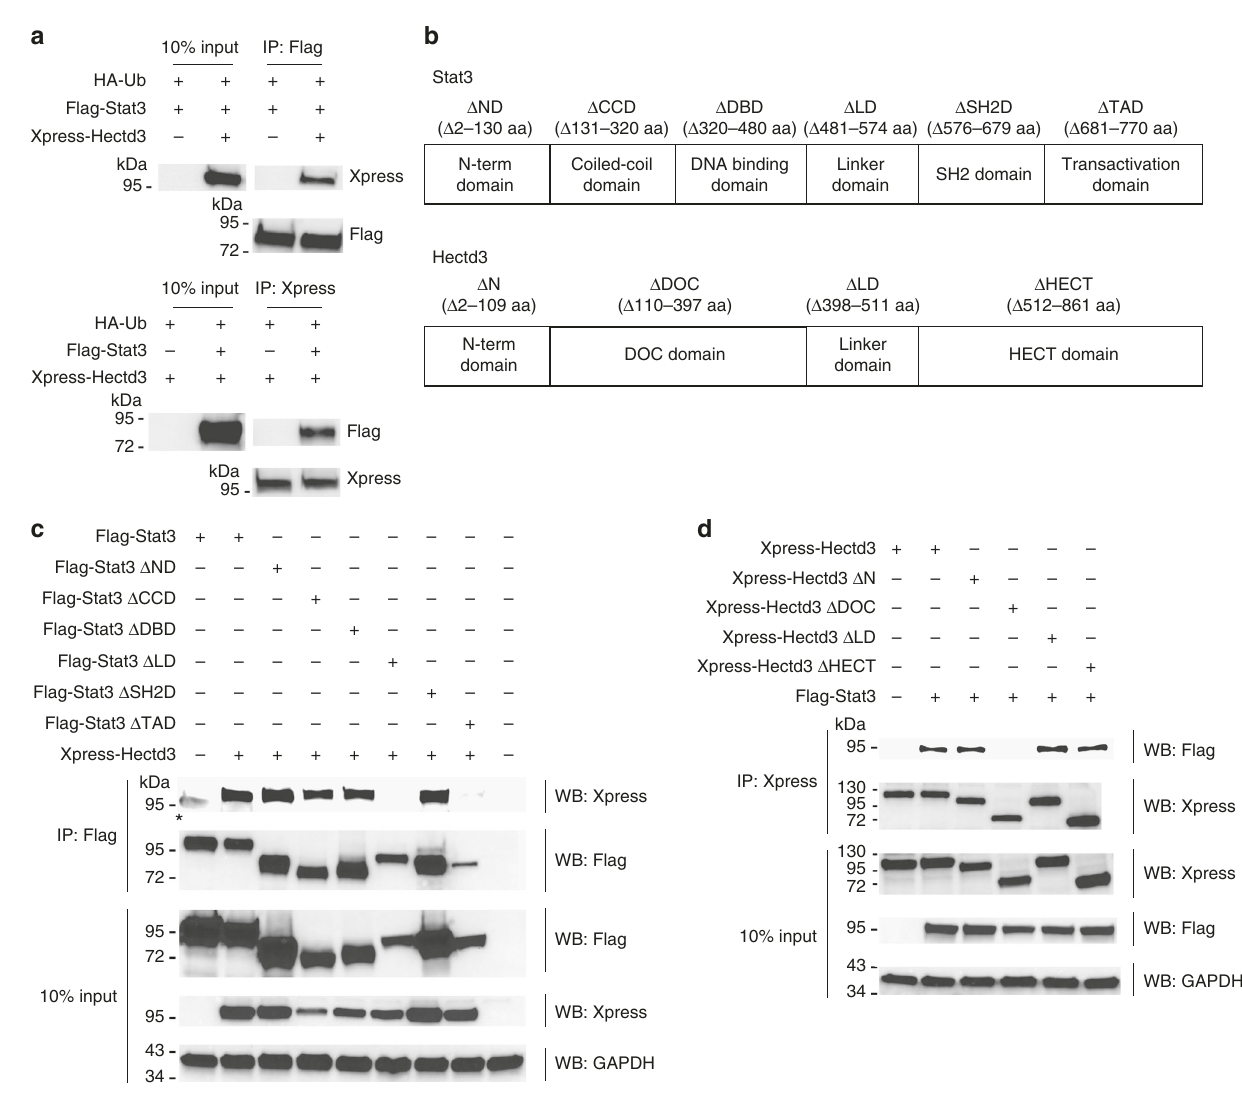
Fig. 9 Stat3 linker region and Hectd3 DOC domain mediate the interaction between Stat3 and Hectd3. a Immunoblot of Xpress and Flag following Flag or Xpress immunoprecipitation of protein extracts from HEK293T cells co-transfected as indicated with HA-Ub, Flag-Stat3, and Xpress-Hectd3; data are representative of three independent experiments. b Stat3 and Hectd3 domains representation. c Immunoblot of Xpress, Flag, and GAPDH in the Flag- immunoprecipitate or input of protein extracts from HEK293T cells co-transfected as indicated with Flag-Stat3, Flag-Stat3 Δ ND, Flag-Stat3 Δ CCD, Flag- Stat3 Δ DBD, Flag-Stat3 Δ LD, Flag-Stat3 Δ SH2D, or Flag-Stat3 Δ TAD, and Xpress-Hectd3; data are representative of two independent experiments. * denotes non-speci fi c bands. d Immunoblot of Flag, Xpress, and GAPDH in the Xpress-immunoprecipitate or input of protein extracts from HEK293T cells co-transfected as indicated, with Xpress-Hectd3, Xpress-Hectd3 Δ ND, Xpress-Hectd3 Δ DOC, Xpress-Hectd3 Δ LD, or Xpress-Hectd3 Δ HECT, and Flag- Stat3; data are representative of two independent experiments. Source data are provided as a Source Data fi